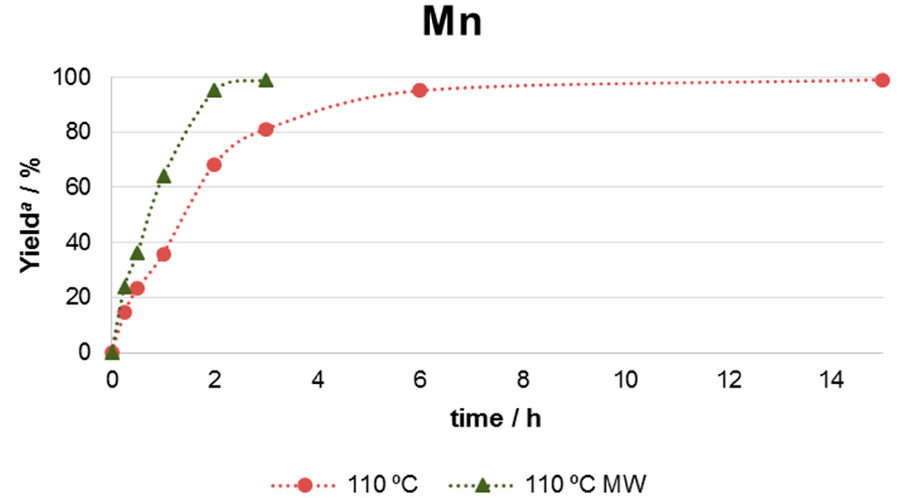
Figure 9. Acetophenone yields vs. reaction time in the solvent-free traditional heated and MW-assisted oxidation of 1-phenylethanol using Fe 3 O 4 @EDTA-Mn 2+ ( 1 ) as catalyst. Reaction conditions: catalyst (30 mg), 1-phenylethanol (2.5 mmol), t -BuOOH aq. 70% (5.0 mmol), T = 110 ◦ C. a Moles of acetophenone per 100 mol of alcohol substrate (GC yield), >99% selectivity.